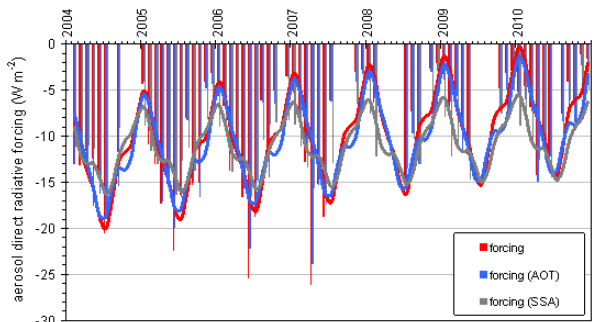
Figure 9. Estimates of the direct aerosol radiative forcing at 550nm (red bars). Blue bars represent the change in aerosol forcing due to variations in AOT, and grey bars the change aerosol forcing due to variations in SSA. Corresponding lines represent the least mean square